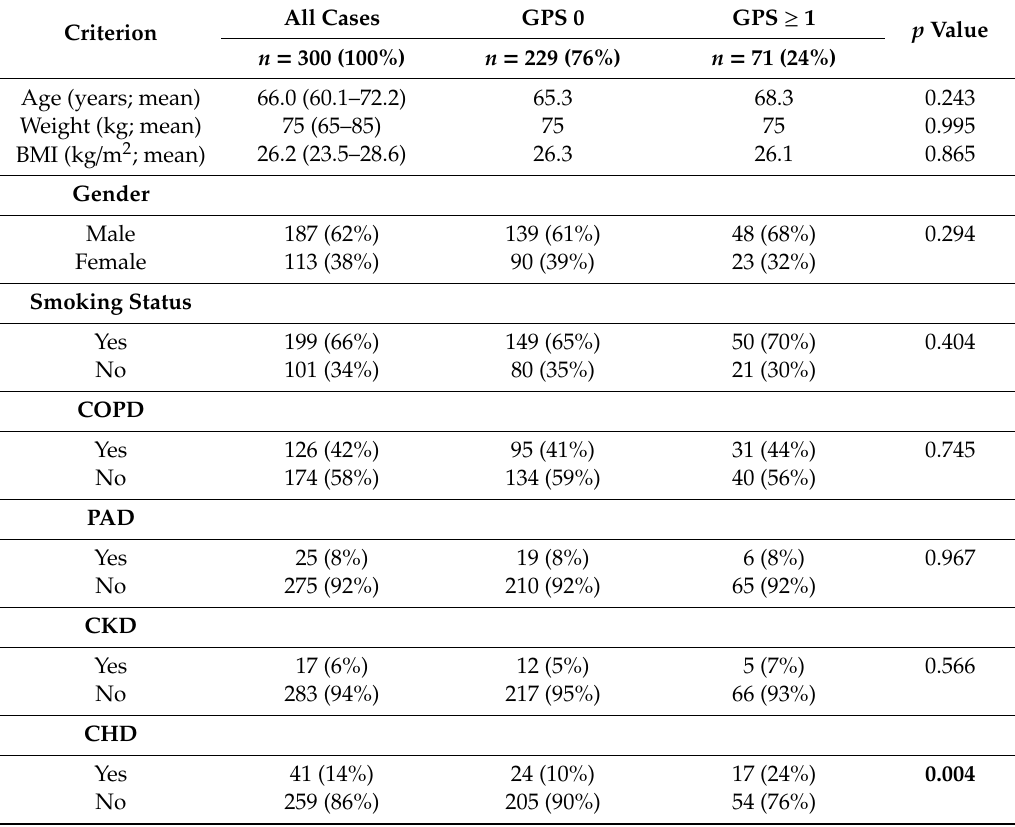
Table 2. Clinico-pathological parameters of 300 patients with stage I NSCLC after curative resection in regard to the calculated preoperative GPS. Abbreviations: GPS, Glasgow Prognostic Score; BMI, body mass index; COPD, chronic obstructive pulmonary disease; PAD, peripheral arterial disease; CKD, chronic kidney disease; CHD, coronary heart disease; CRP, C-reactive